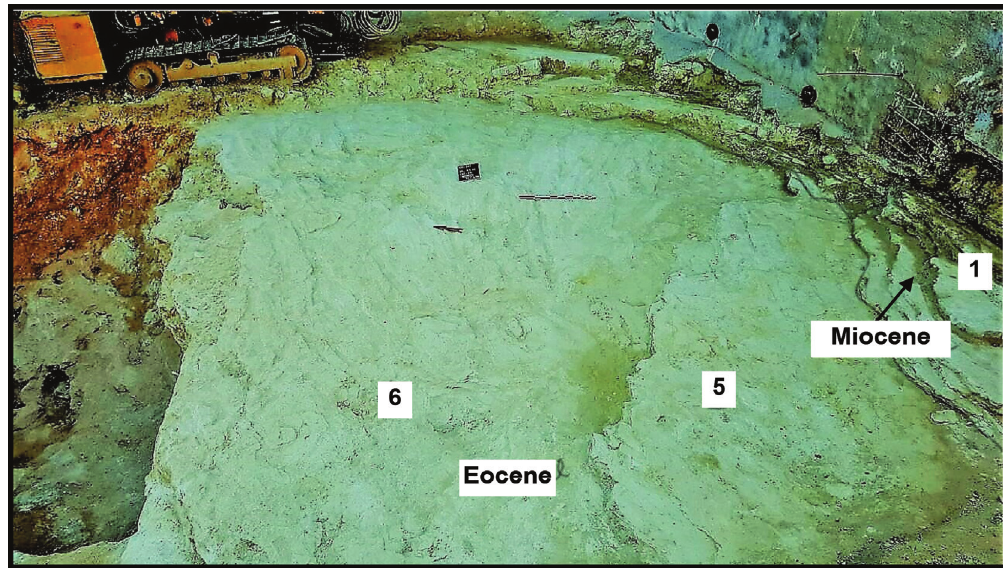
importance: mud sized debris, planktonic foraminifera and rare sub-rounded uppermost Cretaceous lithoclasts. Overall, the environment of deposition of the thin cross-laminated heterogeneous grain supported facies and homogeneous mud supported facies points to shallow water conditions in the back reef–lagoon area close to wave base that is periodically subjected to flooding episodes (see Fig. 3). The high-energy fabrics of their thin beds <15 cm thick suggest a minimal accommodation space rather than slow sedimentation rates. The source of the Cretaceous lithoclasts is likely from